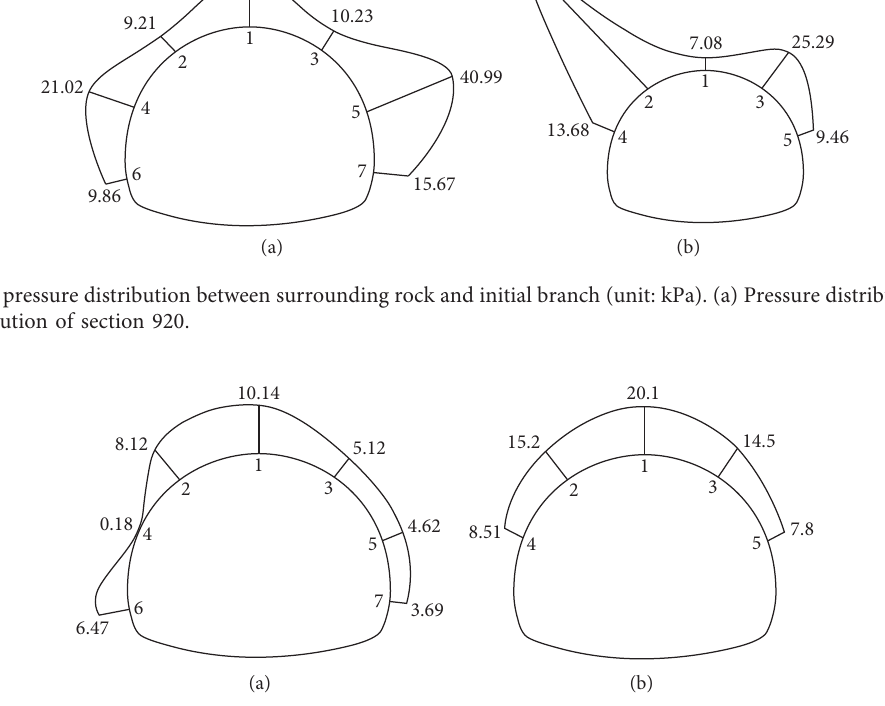
Figure 19: Contact pressure distribution between primary support and secondary lining (unit: kPa). (a) Pressure distribution of section 150. (b) Pressure distribution of section 920.